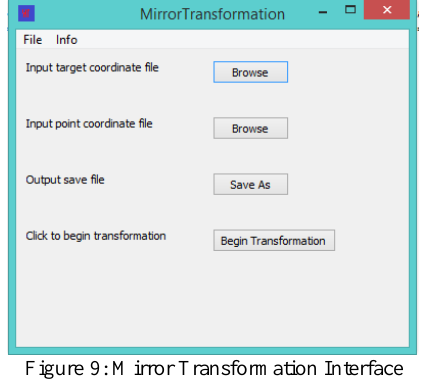
Figure 9: Mirror Transformation